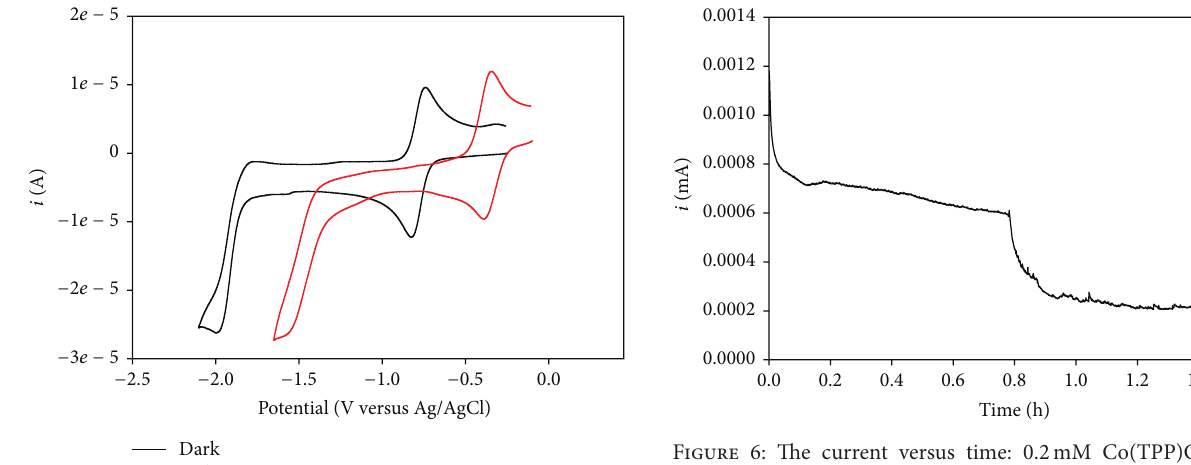
Figure 6: The current versus time: 0.2 mM Co(TPP)Cl in the presence of CO 2 and 0.28 M CF 3 CH 2 OH in MeCN − 5% DMF containing 0.1 M [Bu 4 N][BF 4 ], at p-type Si